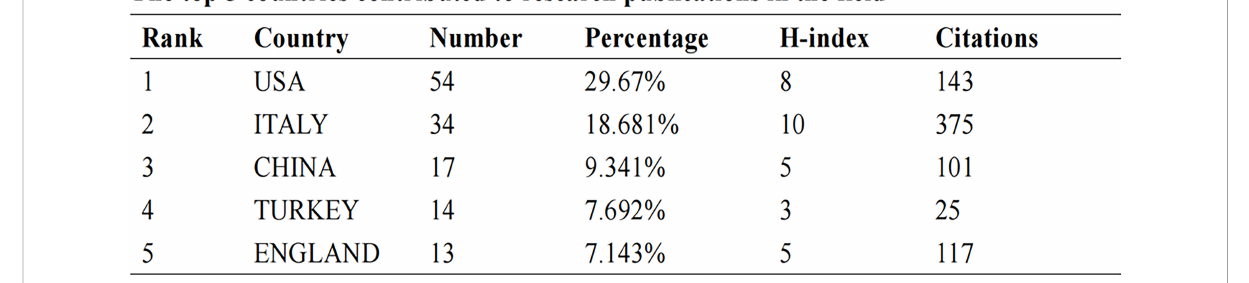
FIGURE 1 The top fi ve countries that contributed to research publications in the fi